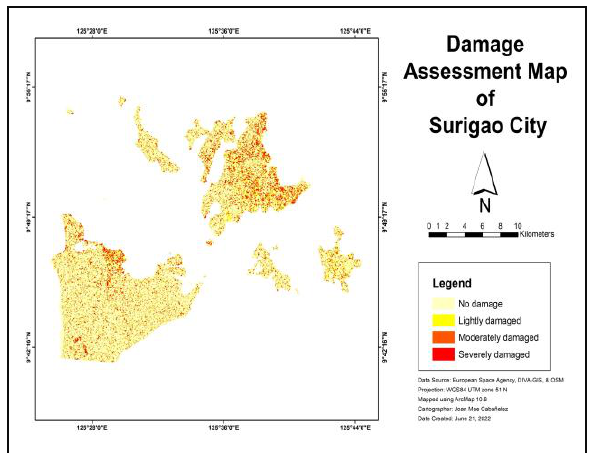
Figure 20 . Coherence-based derived damage assessment map for Surigao City using Sentinel-1 SAR image